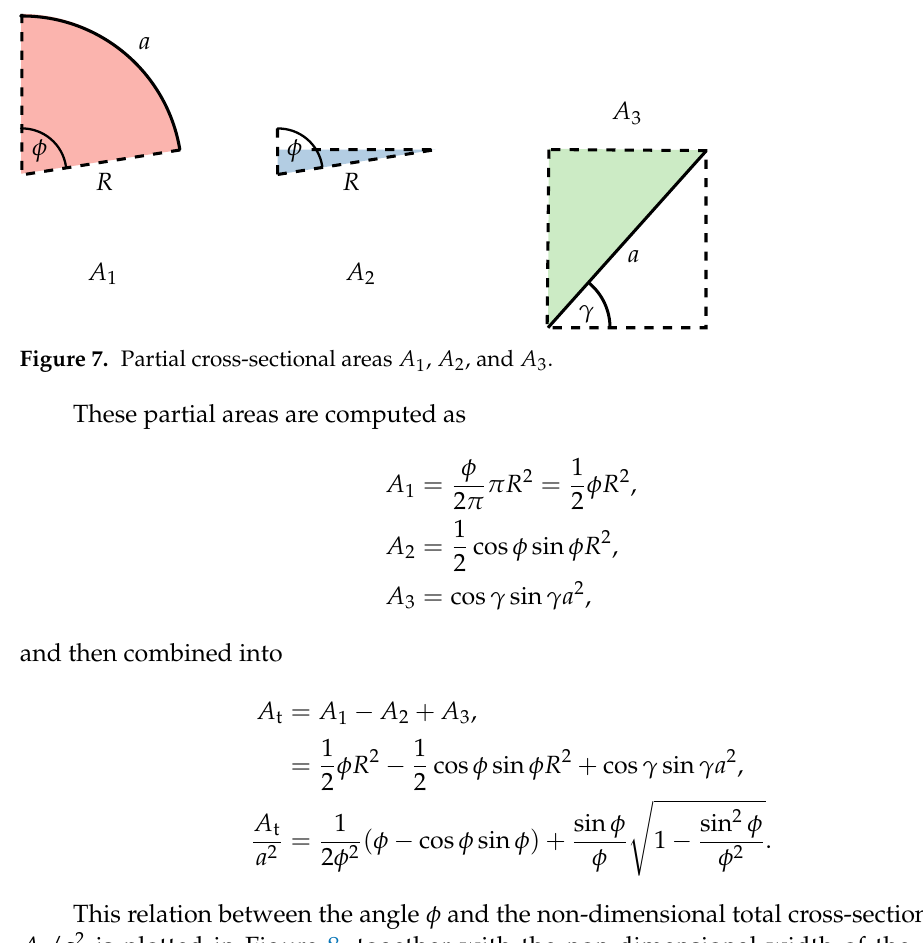
Figure 6. Geometric relations of a conformable-woven mattress cross-section. The total cross-sectional area A t of the inflated quarter segment can be decomposed into the three partial areas illustrated in Figure 7.